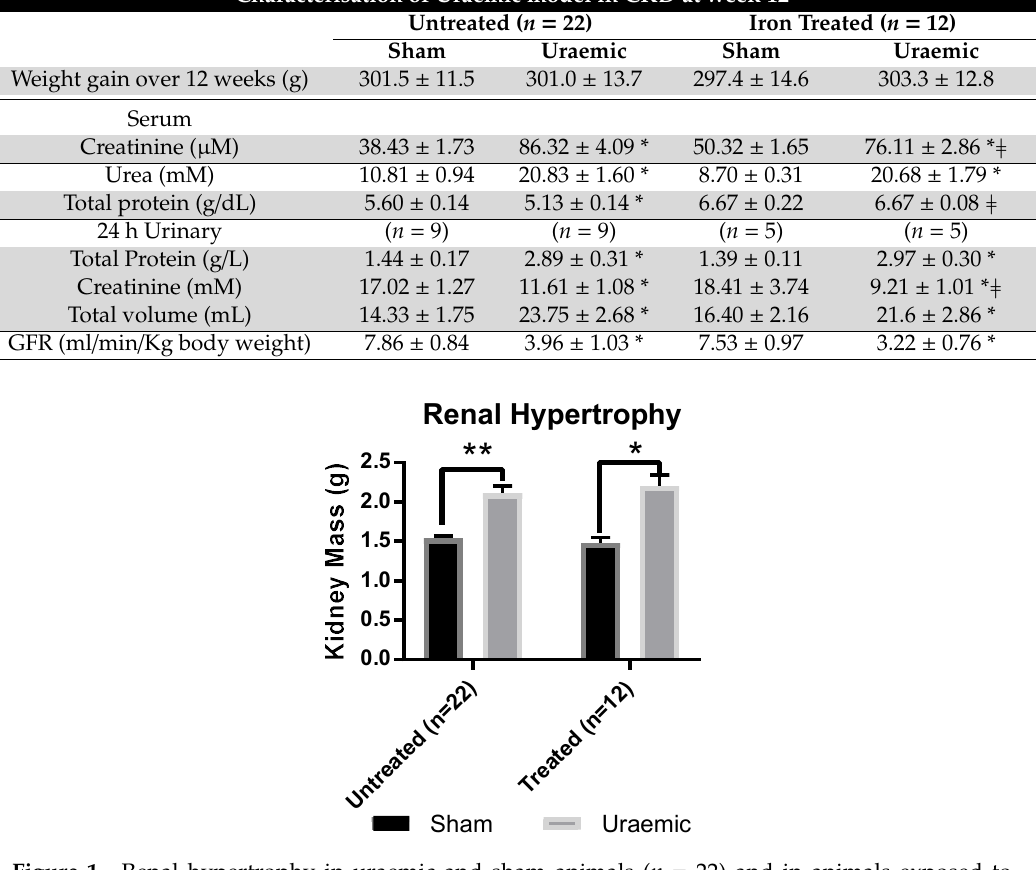
Table 1. Markers of renal function in sham and uraemic animals with and without iv iron. Data are presented as mean ± SEM. GFR (glomerular filtration rate) * p < 0.05; sham versus uraemic; ǂ p < 0.05; uraemic untreated versus treated.